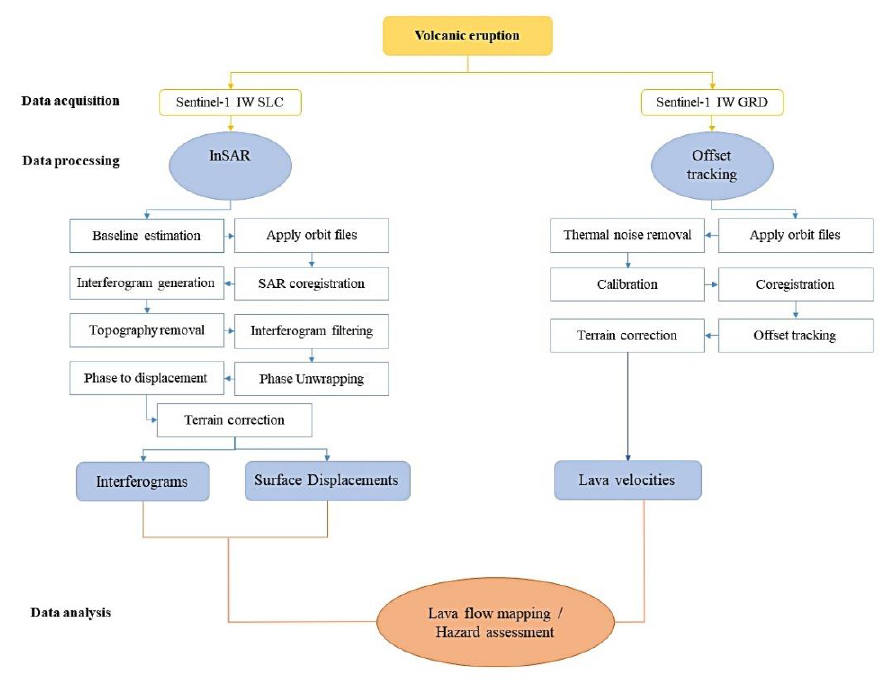
Figure 3. Flowchart describing the applied methodology.